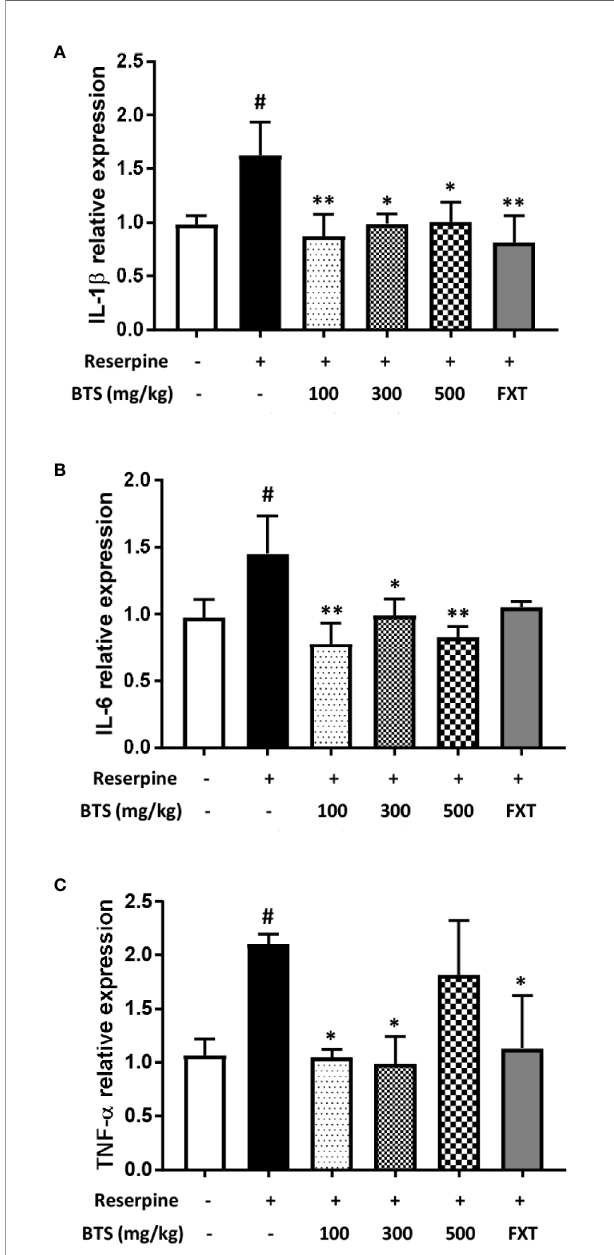
FIGURE 4 | Effects of BTS on Il1b, Il6, and Tnfa mRNA expression in the hippocampus of mice with reserpine-induced depression. (A) mRNA levels of Il1b, (B) Il6, and (C) Tnfa were determined by quantitative real-time PCR. The data represent the mean ± SD of triplicate determinations (n = 6, one-way ANOVA: # p < 0.05 vs. control; *p < 0.05, **p < 0.01 vs.